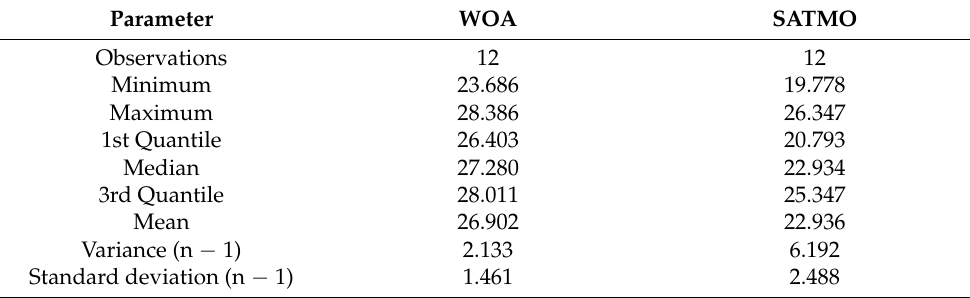
Figure 9. Mean and standard deviations for SATMO, WOA and Marina La Cruz de Huanacaxtle databases. The cross indicates the statistical mean, while the dots indicate the minimum and maximum values. Table 4. Representative statistical data for WOA and SATMO databases.